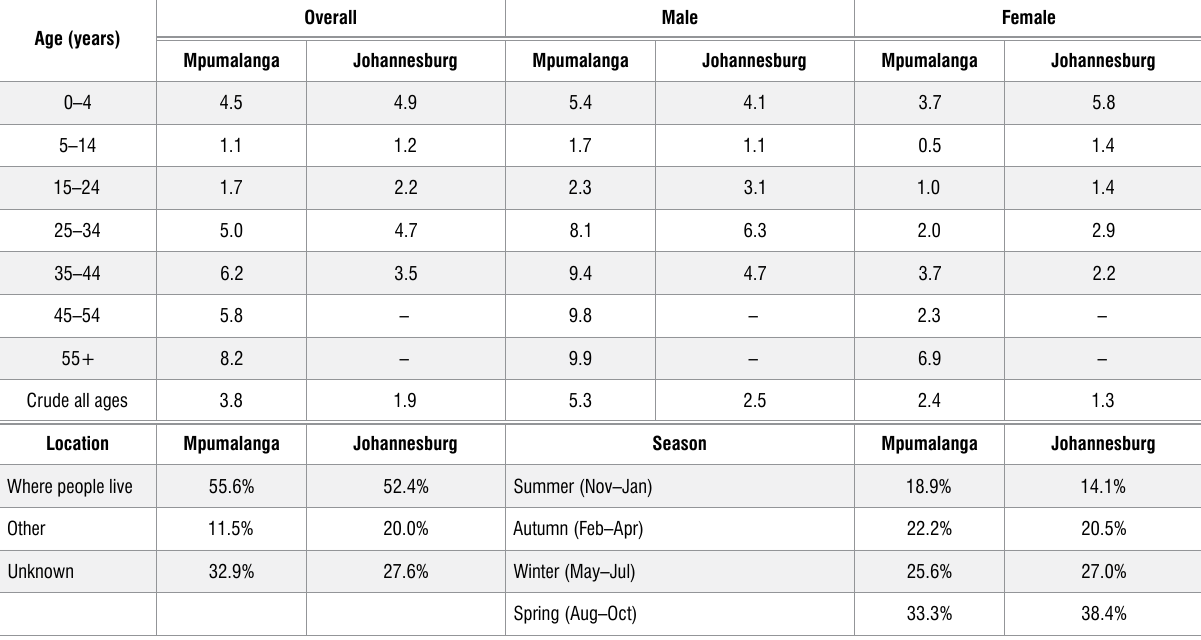
Table 5: Comparison of burn incidence mortality rates (per 100 000) between Johannesburg and Mpumalanga (adapted from Blom et al. 27 )